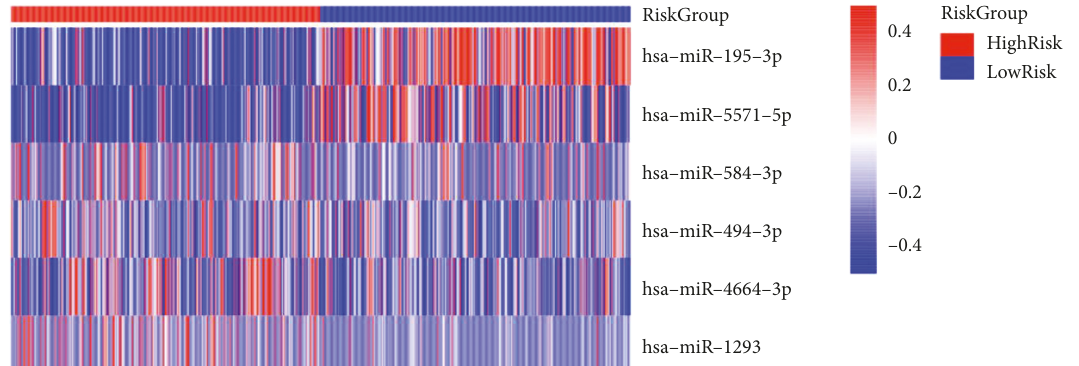
Figure 5: Expression heatmap of six miRNAs was used to construct the prognostic model in the high-risk group and the low-risk